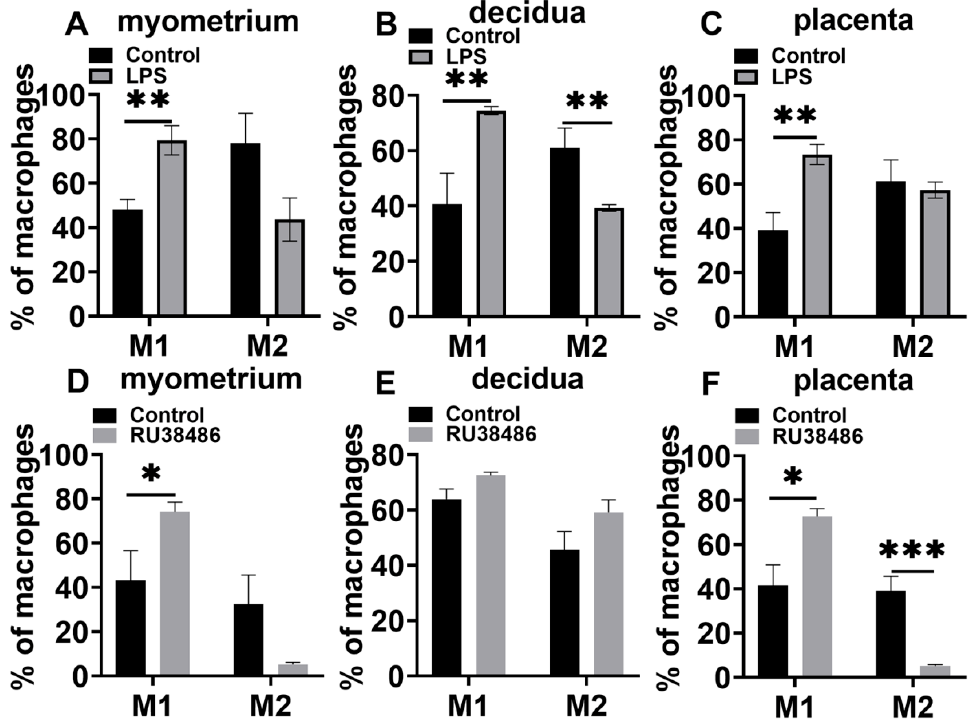
Figure 7. M1 and M2 populations in gestational tissues at preterm labor induced by LPS and RU38486. Pregnant mice were administered LPS ( A – C ) at GD16.25 or RU38486 ( D – F ) at GD16. The mice with LPS or RU38486 were sacrificed after the onset of labor. The control mice were administered the same volume of saline and sacrificed at the corresponding time of LPS or RU38486 group. ( A , D ) Populations of M1 and M2 in myometrium; ( B , E ) populations of M1 and M2 in decidua; ( C , F ) populations of M1 and M2 in placentas. Dye − CD45 + CD11b + F4/80 + iNOS + cells were considered as M1, while Dye − CD45 + CD11b + F4/80 + Arg1 + cells were considered as M2. Data are expressed as mean ± SEM. n = 5 in each group. * p < 0.05, ** p < 0.01, *** p < 0.001.